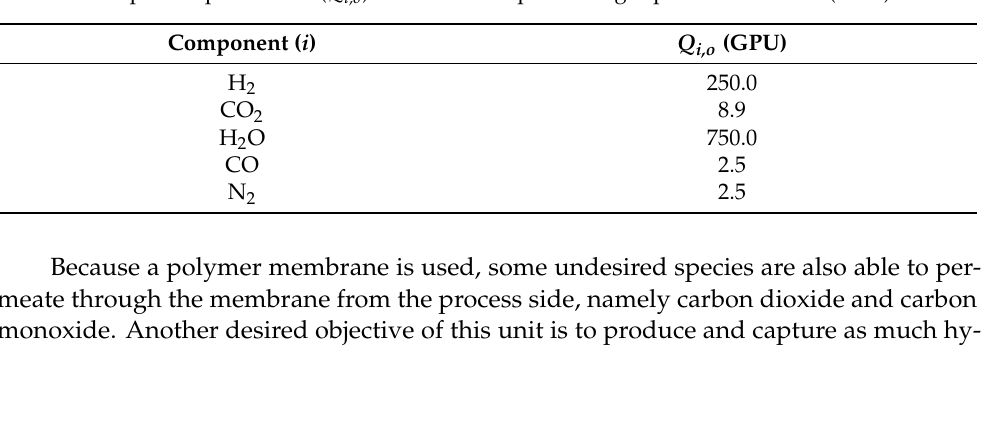
Table 1. Component permeance ( Q i,o ) values used reported in gas permeation units